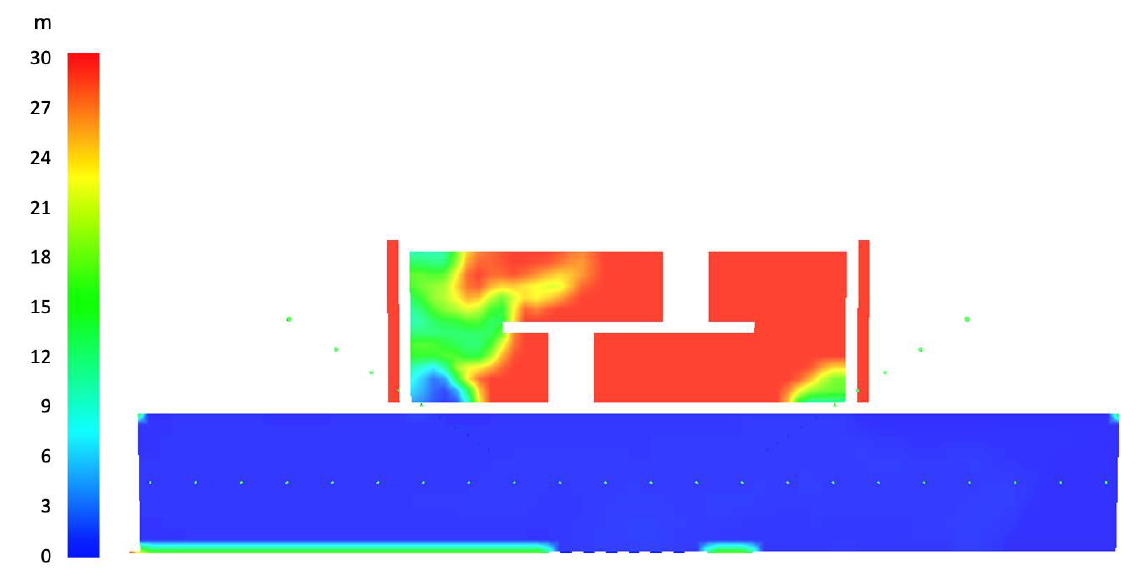
Figure 12. Visibility at time t = 300, with 8 doors open.